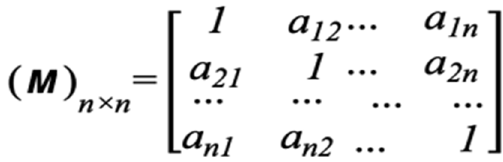
Figure 7. The M pair-wise Matrix.